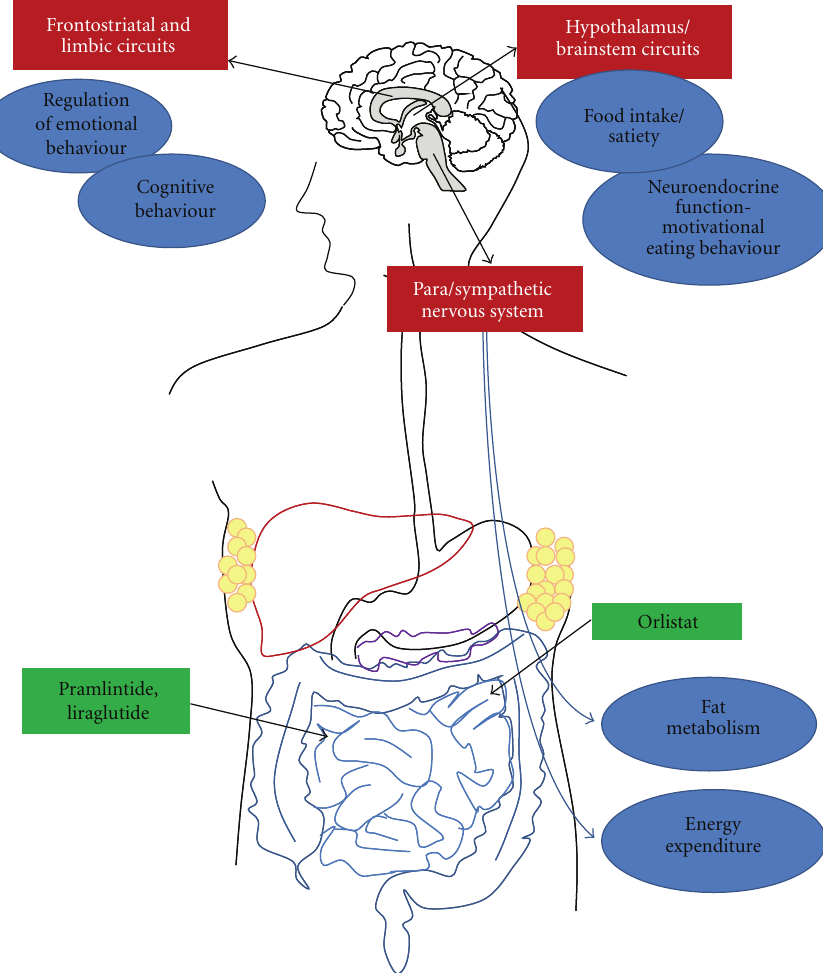
Figure 1: Overview of central and peripheral functions associated with anti-obesity